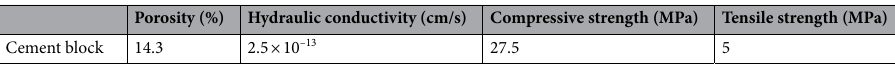
Table 2. Physical and Mechanical properties of the cement